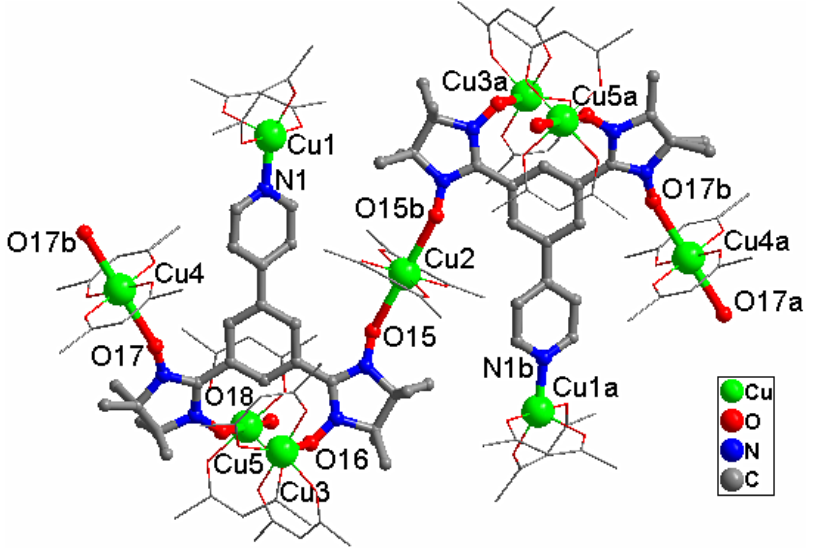
Figure 1. Asymmetric unit of the reticular complex in 1 . The H and F atoms are left out (a: − x + 2, − y, − z; b: − x + 2, − y + 1, − z).